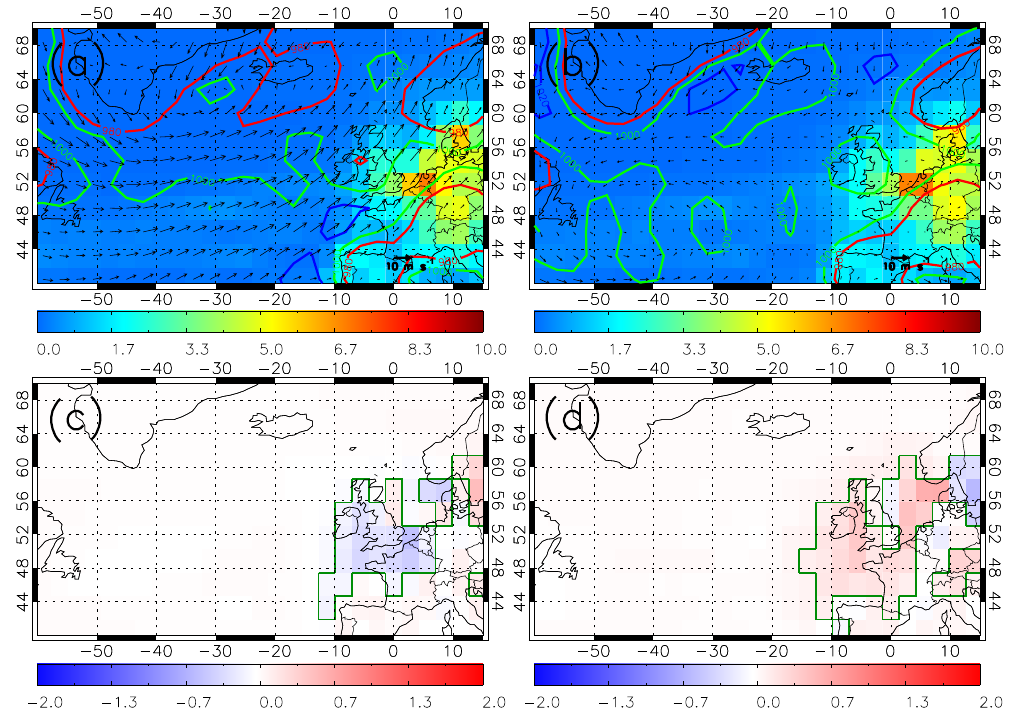
Figure 7. TOMCAT surface NO 2 (ppbv) averaged between 2006 and 2015 sampled under the wintertime (NDJF) NAO. Panel (a) NAO positive phase, (b) NAO negative phase, (c) shows the NAO positive phase anomaly relative to the wintertime average and (d) shows the negative NAO phase anomaly relative to the wintertime average. Wind vectors show the horizontal 10m winds and the red, green and blue contours represent 980, 1000 and 1020hPa. Green polygon-outlined regions in (c) and (d) highlight significant differences at the 95% confidence level based on the